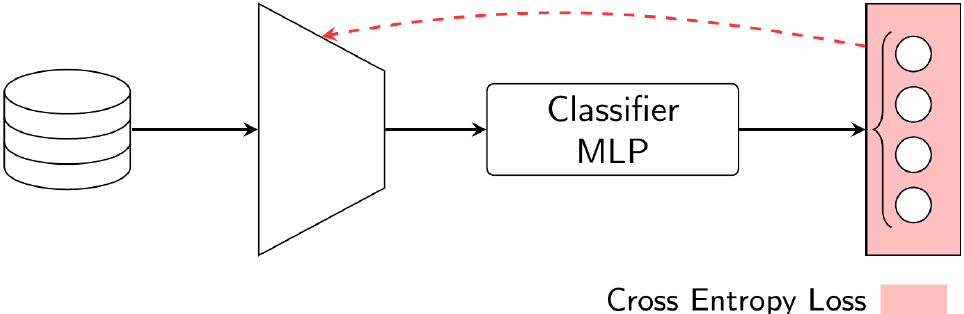
Figure 6. Model architecture in Single Loss Train. The implemented loss is the cross-entropy